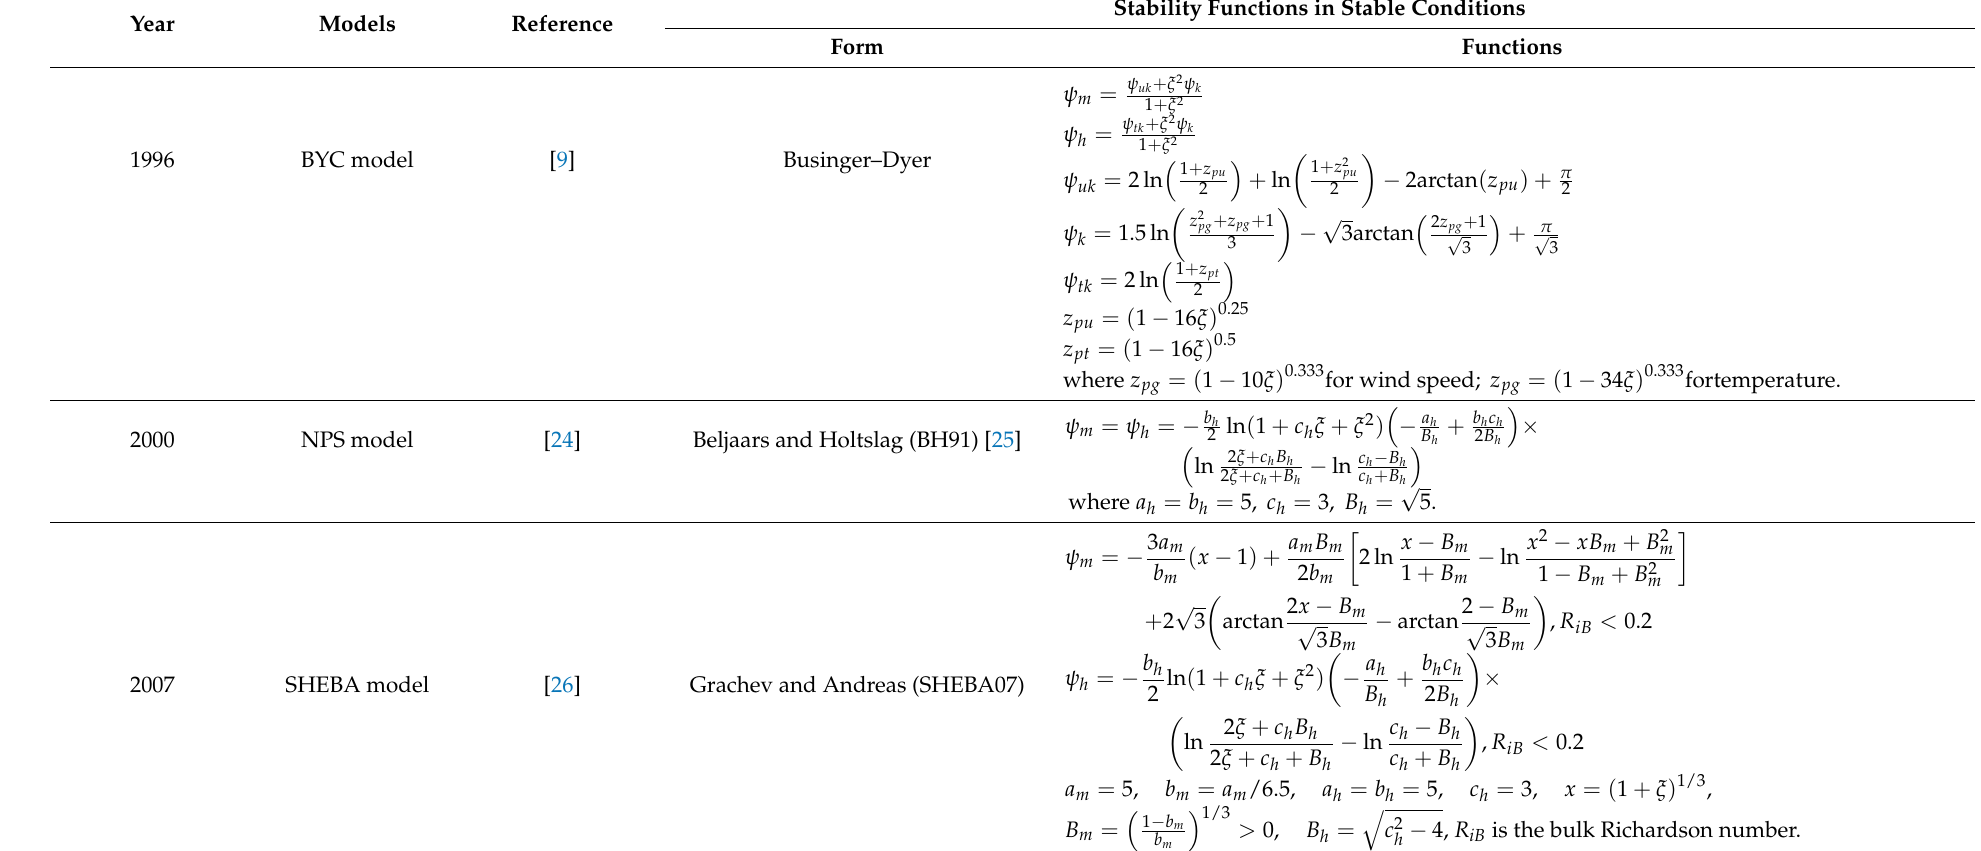
Table 1. The prediction methods of evaporation